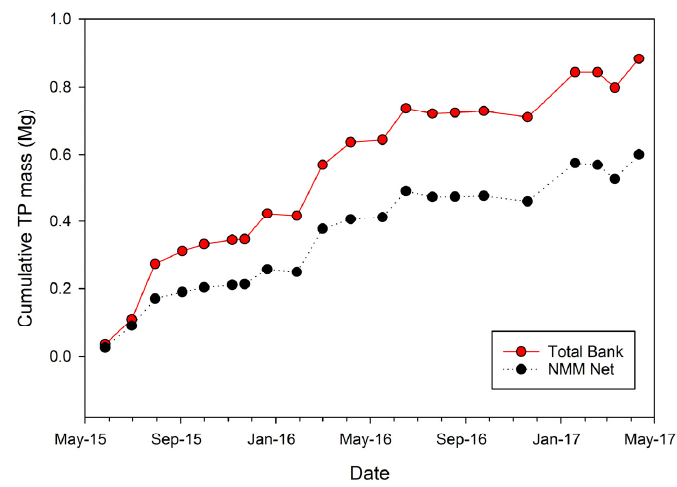
Figure 12. Cumulative mean TP mass loss for NMM Net and total bank, for the main stem of Walnut Creek, Iowa.